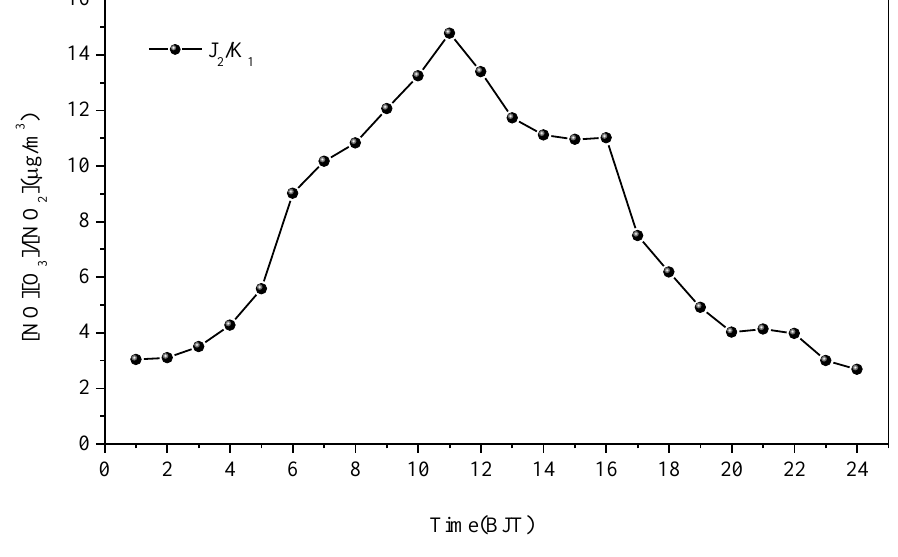
Figure 4. Variation of [NO